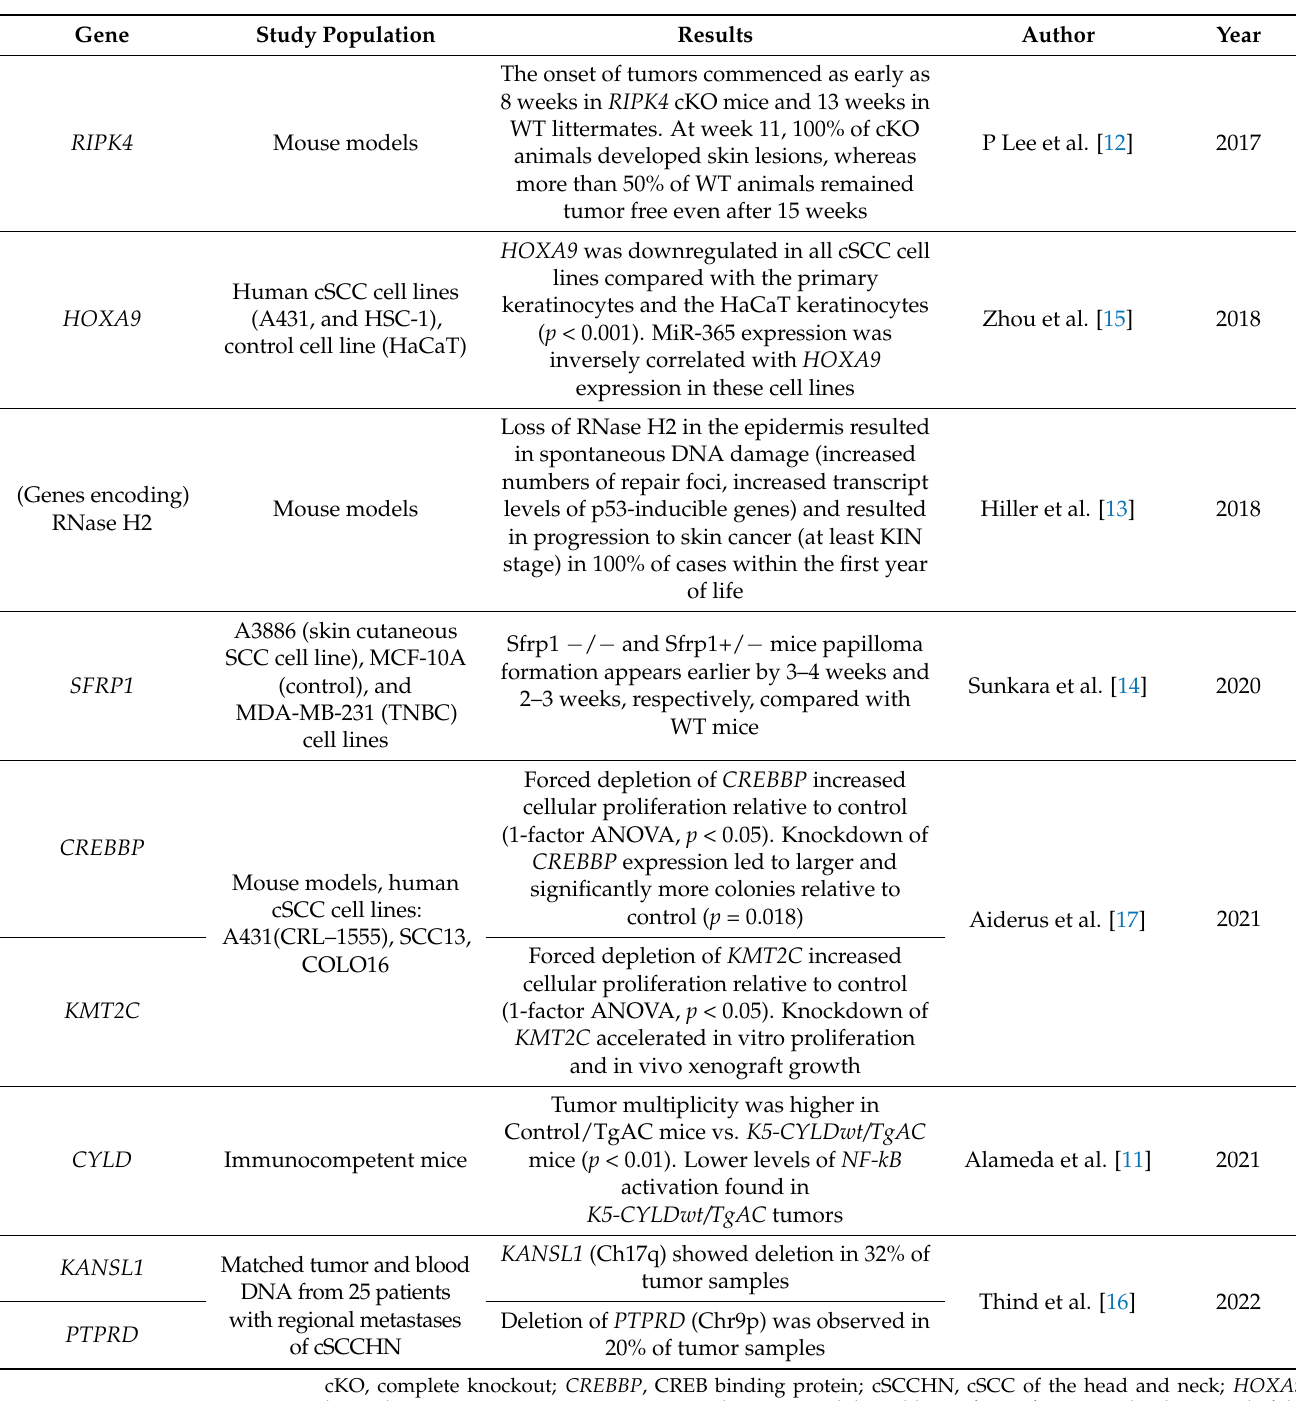
Table 3. Genes with tumor-suppressive